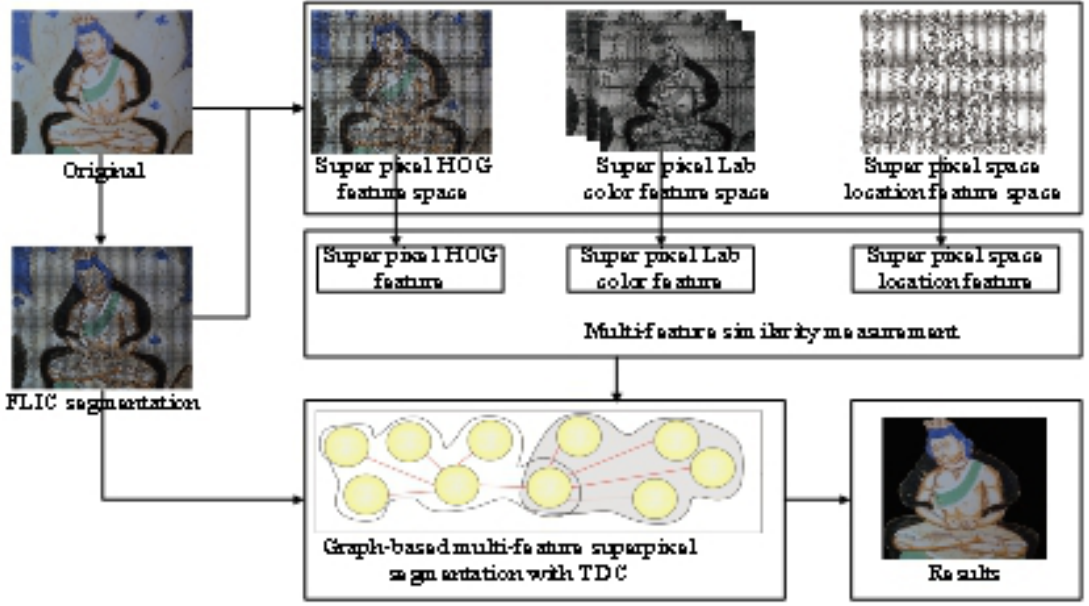
Fig. 1. Proposed art image segmentation